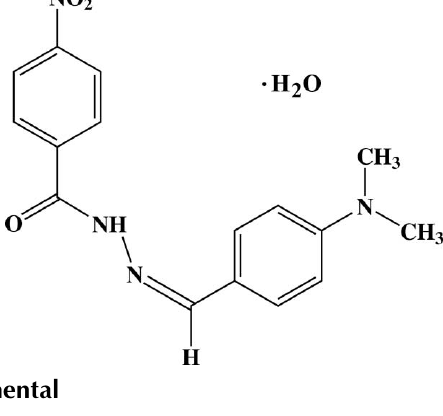
Key indicators: single-crystal X-ray study; T = 100 K; mean (cid:1) (C–C) = 0.002 A˚; R factor = 0.049; wR factor = 0.156; data-to-parameter ratio = 23.9. In the asymmetric unit of the title compound, (cid:1) H C H N O O, there are two symmetry-independent 16 16 4 3 2 hydrazide molecules with almost identical geometries, and two independent water molecules. The dihedral angles between the two benzene rings in the two hydrazide molecules are 0.11 (5) and 0.77 (5) (cid:2) . In one molecule, an intramolecular C—H (cid:1) (cid:1) (cid:1) O hydrogen bond generates a ring of graph-set motif S (5). Intermolecular N—H (cid:1) (cid:1) (cid:1) O, O—H (cid:1) (cid:1) (cid:1) O, O—H (cid:1) (cid:1) (cid:1) N and